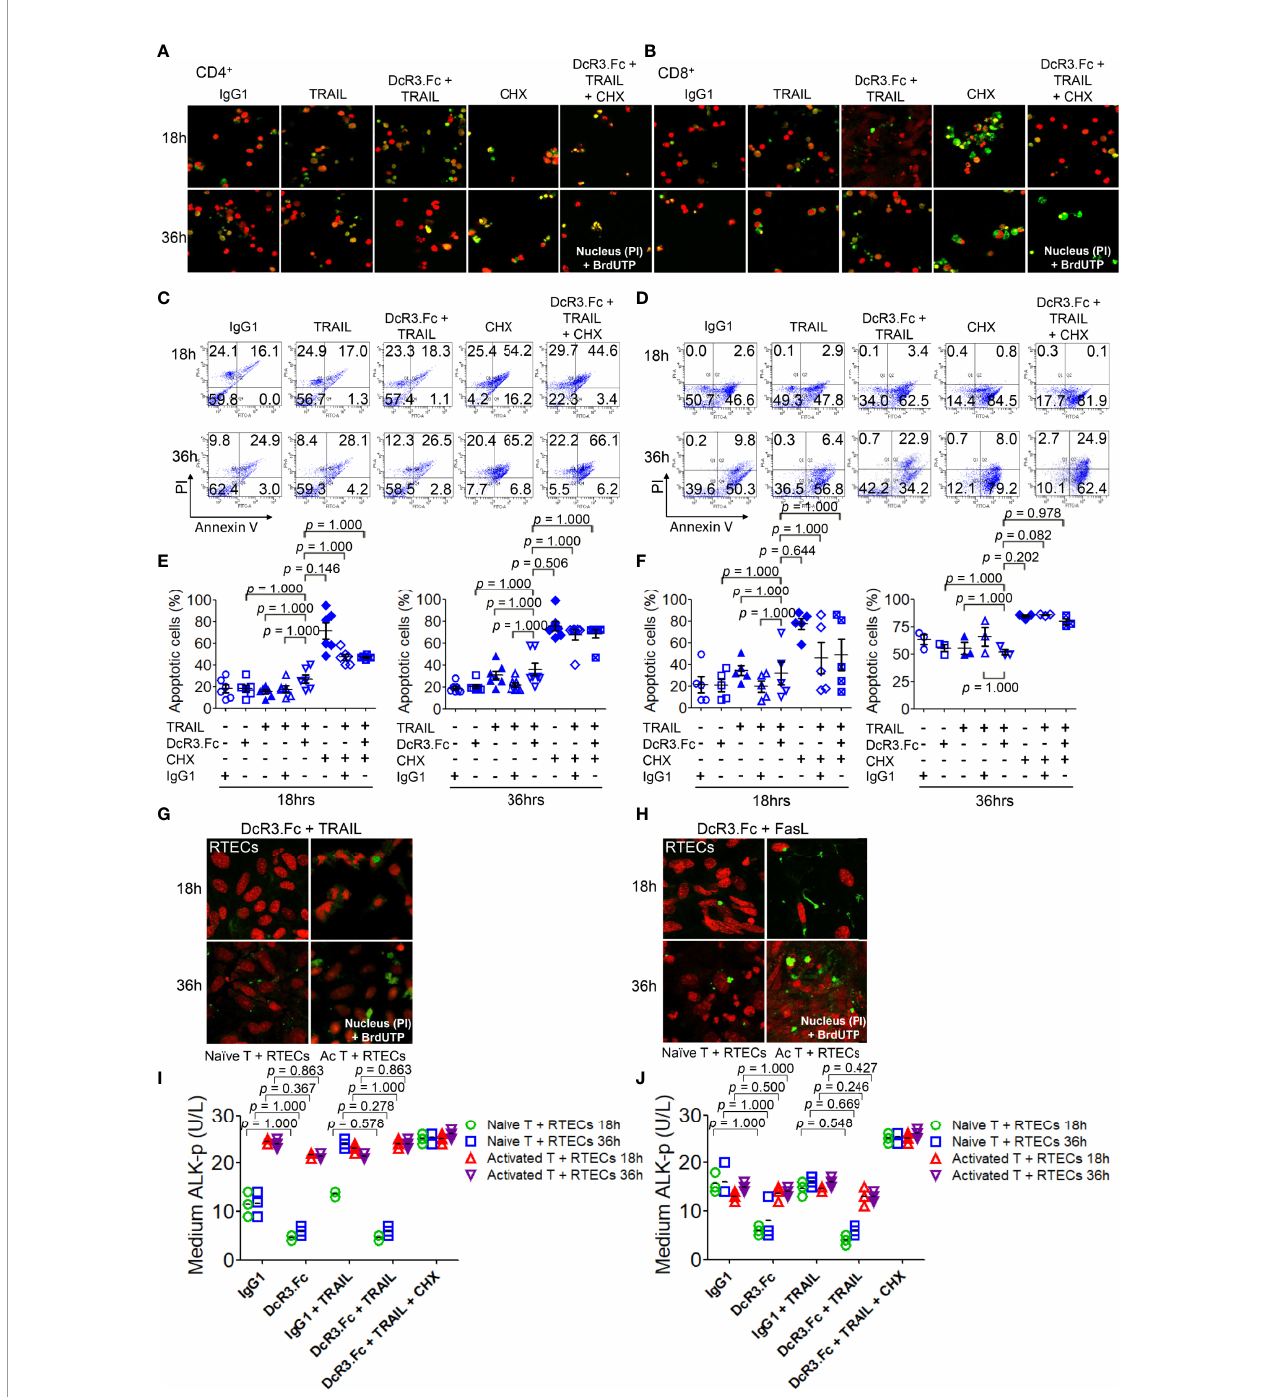
FIGURE 3 | Decoy receptor 3 protects renal tubular epithelial cells (RTECs) from T-cell attack during the priming stage in vitro . (A, B) Terminal deoxynucleotidyl transferase dUTP nick-end labeling (TUNEL) assay of activated CD4 + and CD8 + T-cells, respectively. (C, D) Flow cytometry with Annexin V/PI staining. (E, F) Quantitative data of apoptotic cells of activated CD4 + (IL-2 and anti-CD3)/CD8 + (IL-2 and anti-CD3 and anti-CD28) T-cells were evaluated by the Kruskal – Wallis test, followed by Bonferroni post-hoc analysis for multiple testing. (E, F) are part of a summary of (C, D) . (G, H) TUNEL assay of RTECs co-cultured with naïve or activated CD4 + /CD8 + T-cells. (I, J) Medium alkaline phosphatase (ALK-p) of the RTECs co-cultured with naïve or activated CD4 + or CD8 + T-cells, respectively, was analyzed by Kruskal – Wallis test, followed by Bonferroni post-hoc analysis, and those data were presented as mean ± SD. One set of the representative data from at least three experiments ( n = 3) is shown. The group with cycloheximide was a positive control of apoptosis. IgG1, human IgG1; CHX, cycloheximide; naïve T, from female LN cells or spleen; activated T, female naïve T-cells activated by male bone marrow-derived dendritic cells +